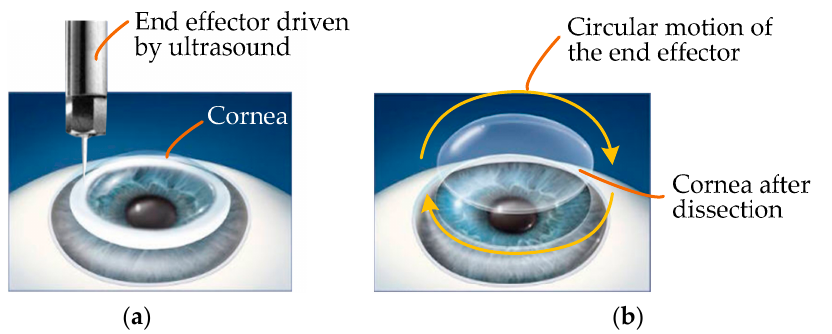
Figure 4. Conceptual diagram of ultrasound-assisted corneal trephination. ( a ) The cornea is cut by an end effector driven by ultrasound. ( b ) The end effector can move in a circle to simulate the operation of a trephine. In lamellar keratoplasty, the diseased part of the cornea can be removed by dissection when the cornea is trephined to a certain depth.